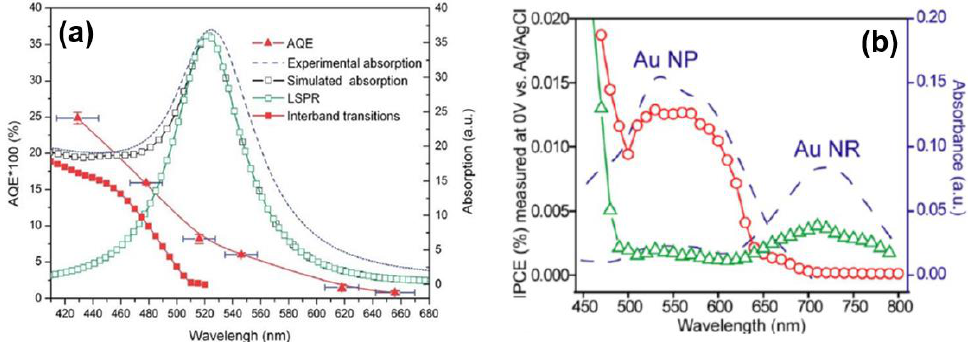
Figure 26. ( a ) A study of the apparent quantum efficiencies, by Liu et al. [158], to determine the driving force in photocatalysis of O 2 evolution on 1.1% Au/SrTiO 3 at various wavelengths of light. The important observation from these results being that water oxidation over the Au/SrTiO 3 composite is not driven primarily by LSPR related phenomena. This is noted by the fact that the AQE curve for O 2 evolution bears a strong resemblance to that of interband transitions suggesting that the visible light photosensitization effect of Au arises mainly from interband transitions. This fact is further supported in the results by the substantially negligible O 2 evolution over Ag/SrTiO 3 under visible light [158] as interband transitions of Ag are excited only in the UV spectrum through plasmon resonance, and observed in the visible region. Reprinted with permission from Ref [158] Copyright Royal Society of Chemistry (2014). ( b ) Shows the quantum efficiencies at a bias of 0 V vs Ag/AgCl for photoelectrochemical water splitting using plasmonic gold nanoparticle decorated TiO 2 nanowires and gold nanorod decorated TiO 2 nanowires, which follow the LSPR absorption profile. Reprinted with permission from Ref [286] Copyright American Chemical Society (2013).